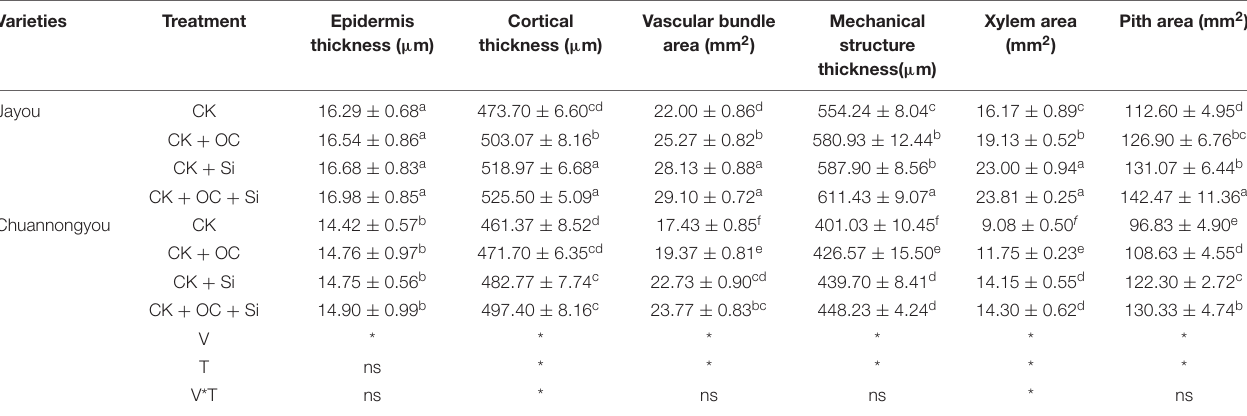
Different lower-case letters indicate significant differences among treatments at p ≤ 0.05 (LSD test) with the means (n = 3) of values. The CK, CK + OC, CK + Si, and CK + OC + Si represent the conventional fertilization, conventional + organic carbon fertilization, conventional + silicon fertilization treatment, and conventional + organic carbon + silicon fertilization treatment. V, T, and Y represent the variety, treatment, and year, while * and ns indicate the significance and non-significance, respectively.